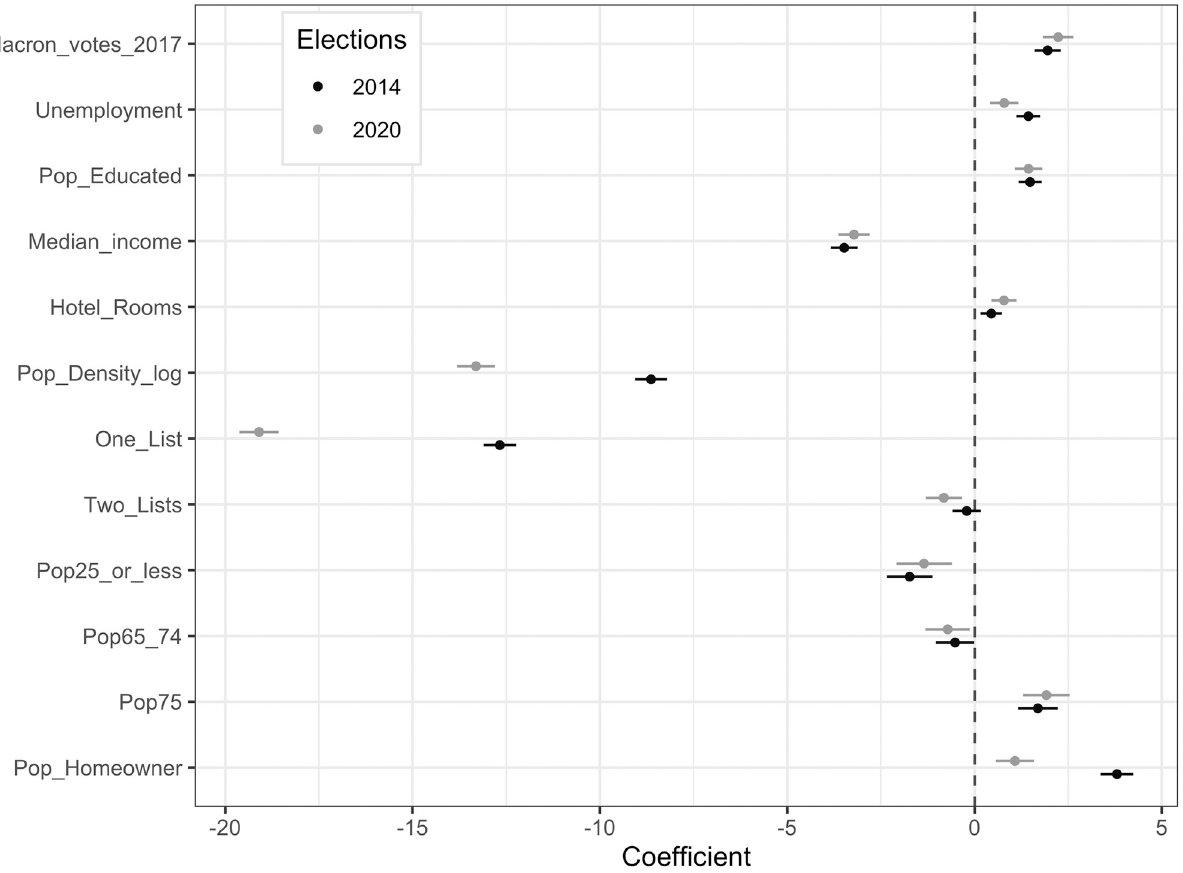
Fig 5. Estimated coefficients at the 2014 and 2020 elections for turnout rate